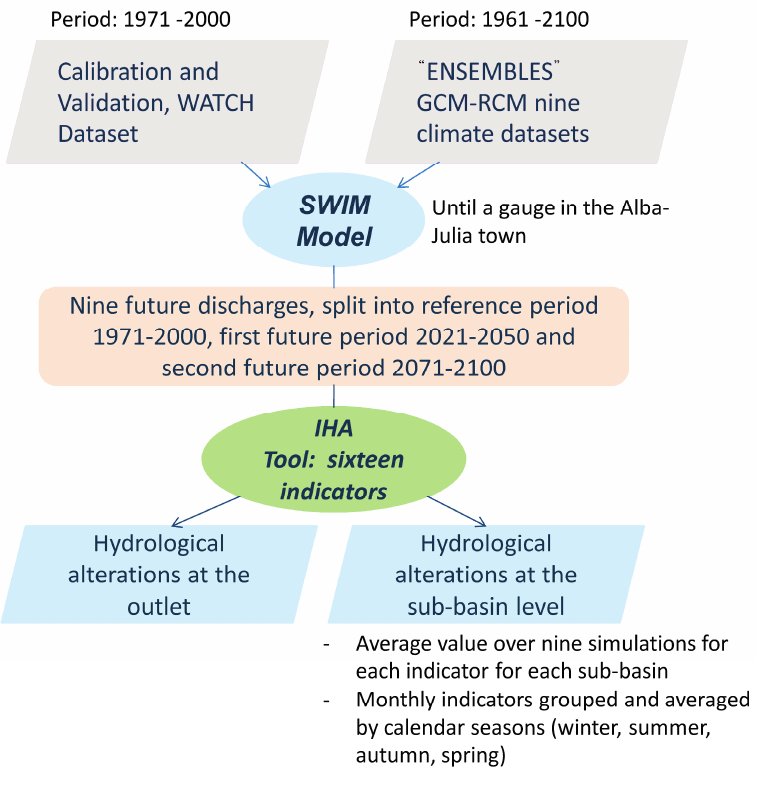
Figure 2. Diagram of the workflow